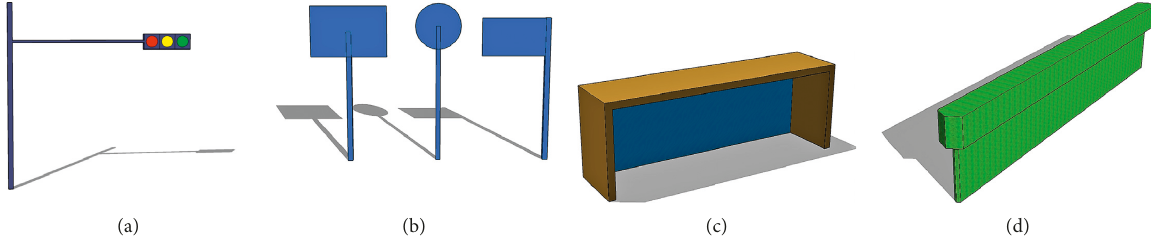
Figure 3: 3D models of small-scale structures. (a) Traffic light model. (b) Traffic sign model. (c) Bus station model. (d) Tree model.